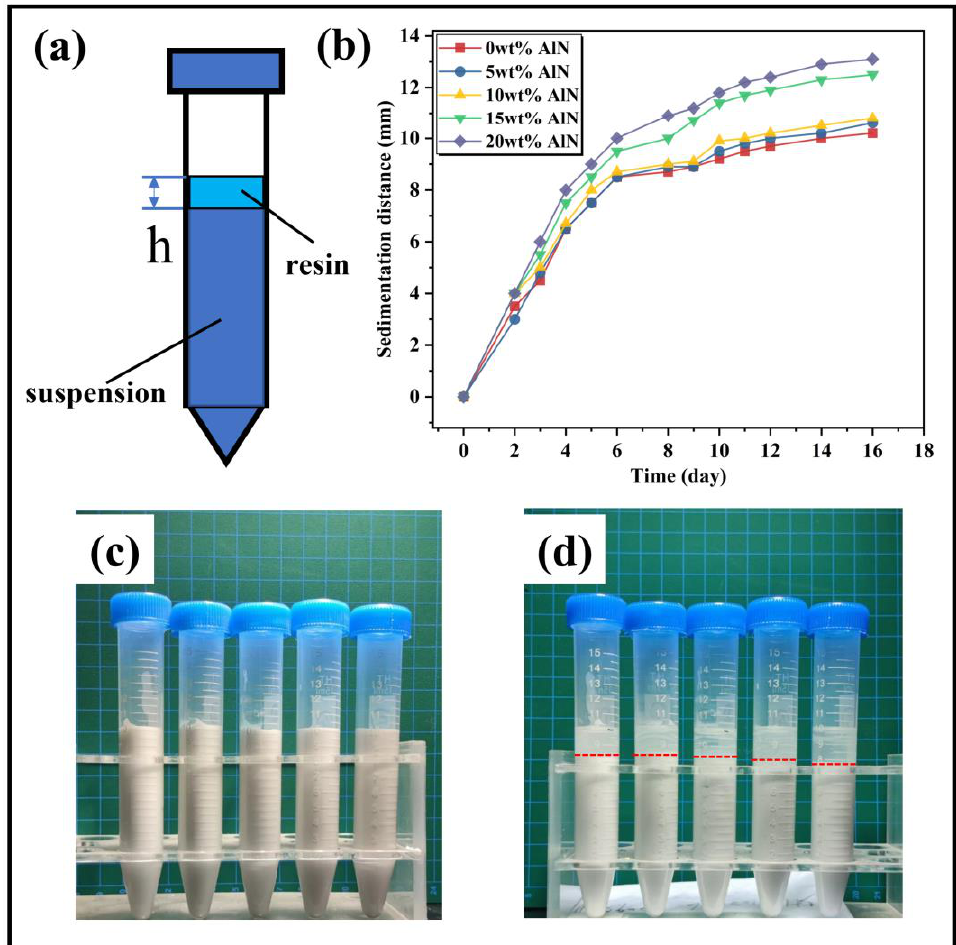
Figure 2. ( a ) Diagram of sedimentation distance; ( b ) Sedimentation height of the suspensions with different content of AlN after different times; ( c ) Photograph of sedimentation distance after 0 days; ( d ) Photograph of sedimentation distance after 14 days.